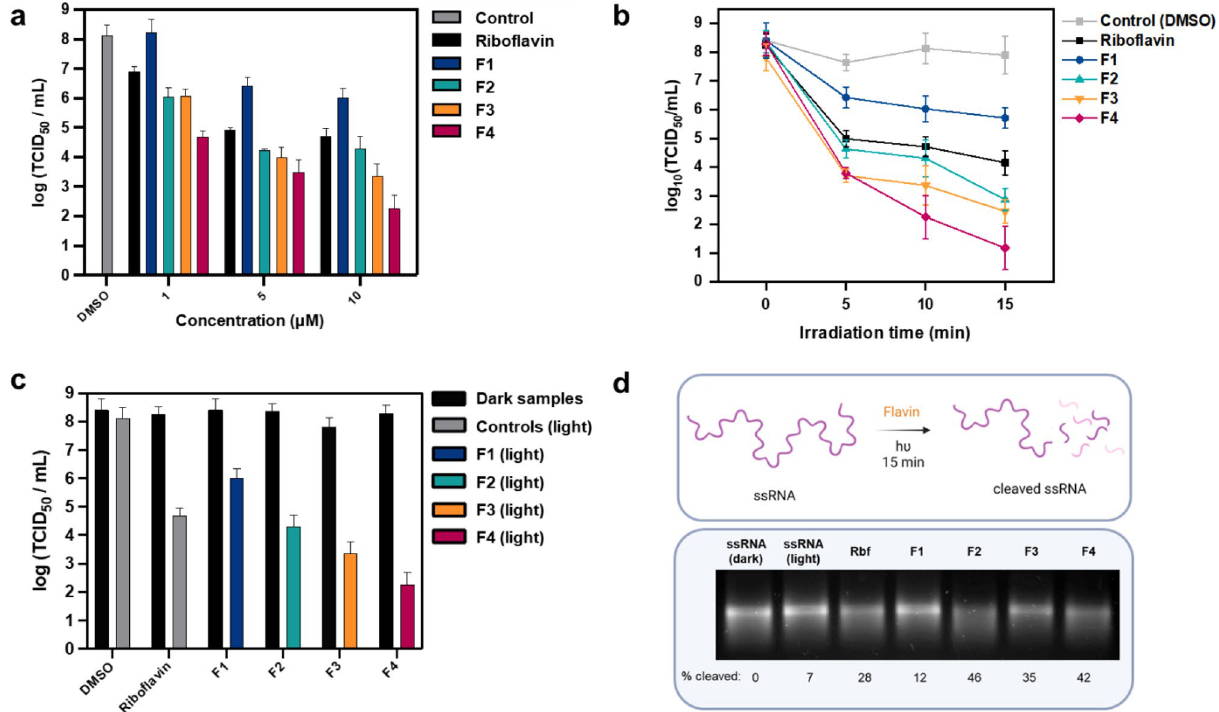
Figure 4. Photodynamic inactivation of murine hepatitis virus (MHV-A59). ( a ) Photodynamic inactivation of murine hepatitis virus A59 strain (MHV-A59) incubated with various concentrations of flavins irradiated with white LED light (1 × 10 5 lx, 35 mW/cm 2 ) for 10 min in PBS containing 0.1% DMSO. Data are expressed as the mean ± SD of three biological replicates. ( b ) Time course of MHV-A59 inactivation incubated with 10 µM of flavin irradiated with white LED light (1 × 10 5 lx, 35 mW/cm 2 ) for 15 min in PBS containing 0.1% DMSO. Data are expressed as the mean ± RE of three biological replicates. ( c ) Photodynamic inactivation of MHV- A59 incubated with 10 µM of flavin compound irradiated with white LED light (1 × 10 5 lx, 35 mW/cm 2 ) or incubated in the dark for 10 min in PBS containing 0.1% DMSO. Data are expressed as the mean ± SD of three biological replicates. ( d ) Agarose gel electrophoresis of ssRNA following incubation with 10 µM flavin irradiated with white LED light (1 × 10 5 lx, 35 mW/cm 2 ) for 15 min in PBS containing 0.1% DMSO. Rbf = Riboflavin. Uncropped gel electrophoresis image is shown in ESI Figure